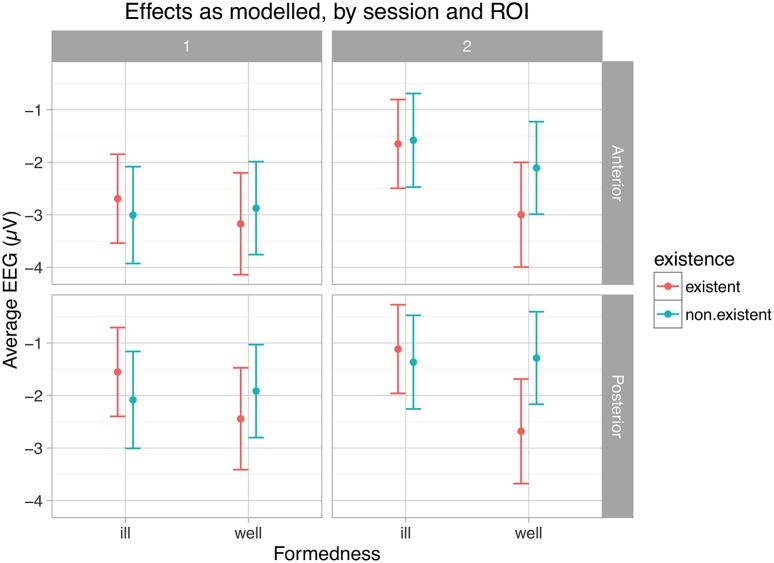
Main effects and interactions for the time window 700–1050 ms. EEG-sessions are denoted by 1 and 2, ROIs by Anterior and Posterior.